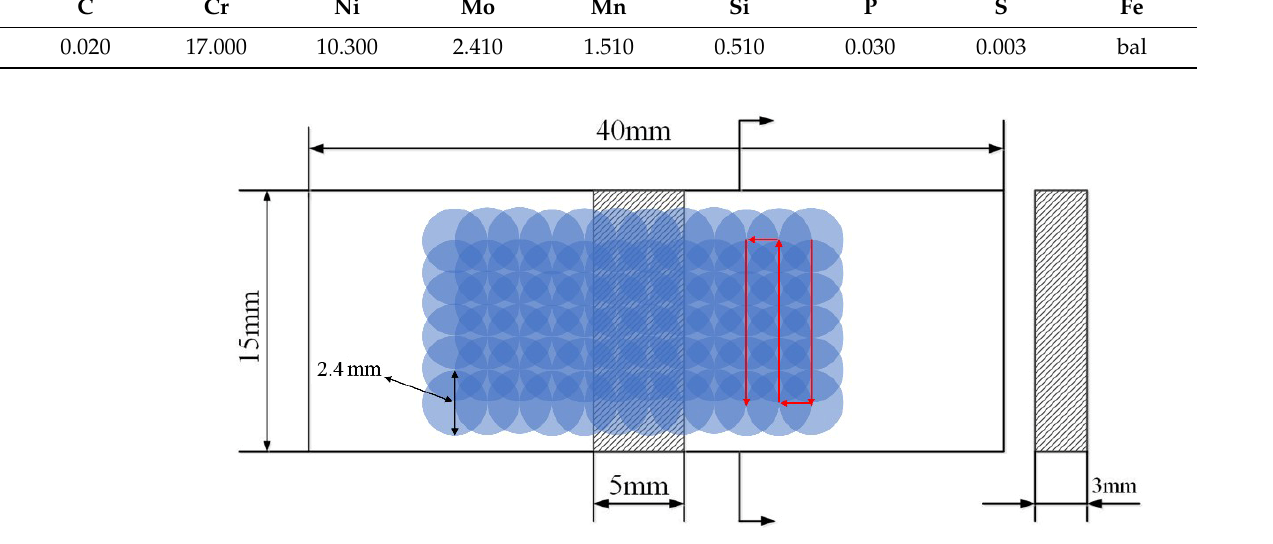
Figure 1. Schematic map of laser shock